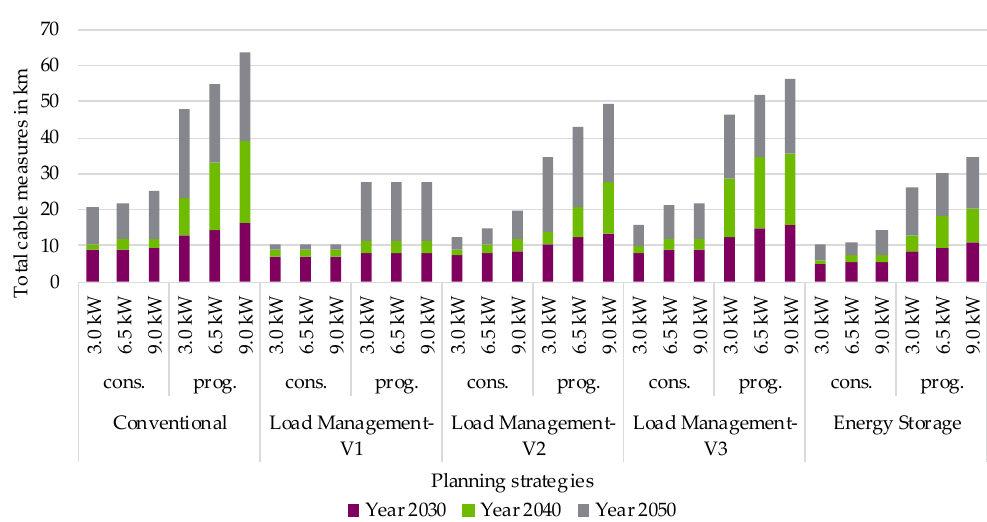
Figure 9. Consolidated cable measures for the medium voltage grids with different planning strategies over the investigated years for the two development scenarios and the three heat pump systems.